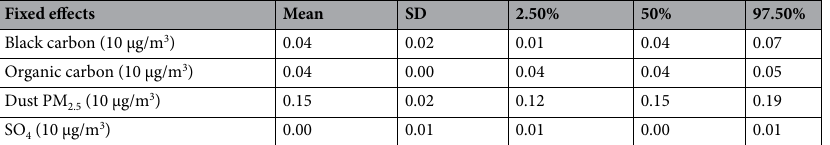
Table 3. Posterior marginals by multivariate analysis for linear predictor incidence rates ratio and computed fitted values of colon cancer. SD standard